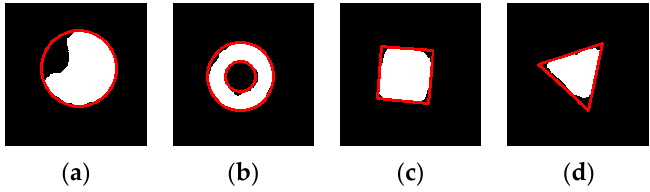
Figure 7. The integrity contour of various marking points: ( a ) The solid circle with integrity contour, ( b ) The hollow circle with integrity contour, ( c ) The square with integrity contour, and ( d ) The triangle with integrity contour.